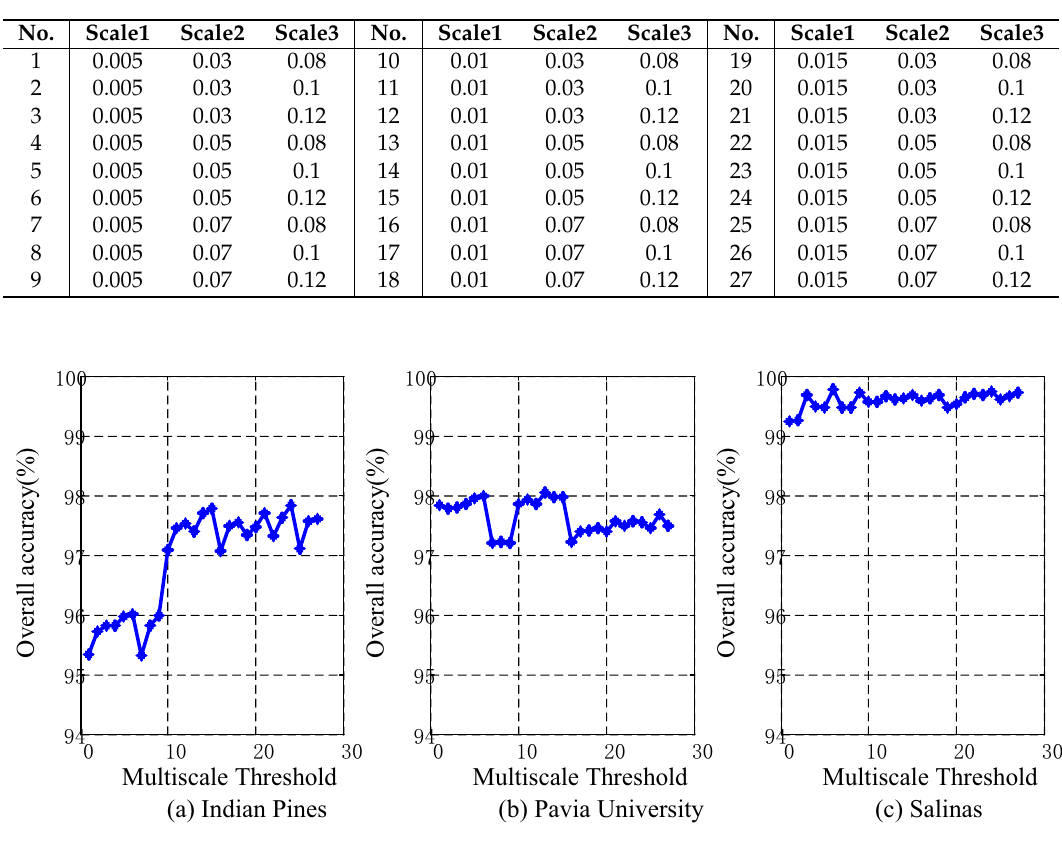
Figure 10. Overall classification accuracy with different multiscale threshold